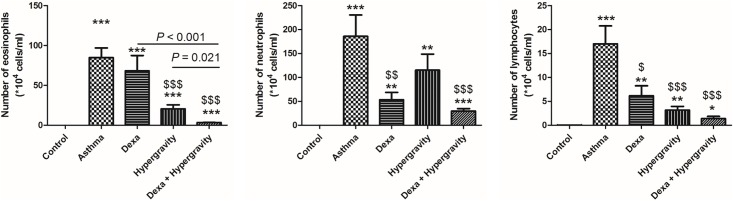
Number of eosinophils, neutrophils, and lymphocytes in the broncho-alveolar lavage fluid.* Significant difference from the control group, p < 0.05; ** significant difference from the control group, p < 0.01; *** significant difference from the control group, p < 0.001; $ significant difference from the asthma group, p < 0.05; $ $ significant difference from the asthma group, p < 0.01; $ $ $ significant difference from the asthma group, p < 0.001 (the Kruskal-Wallis and Mann-Whitney U tests).